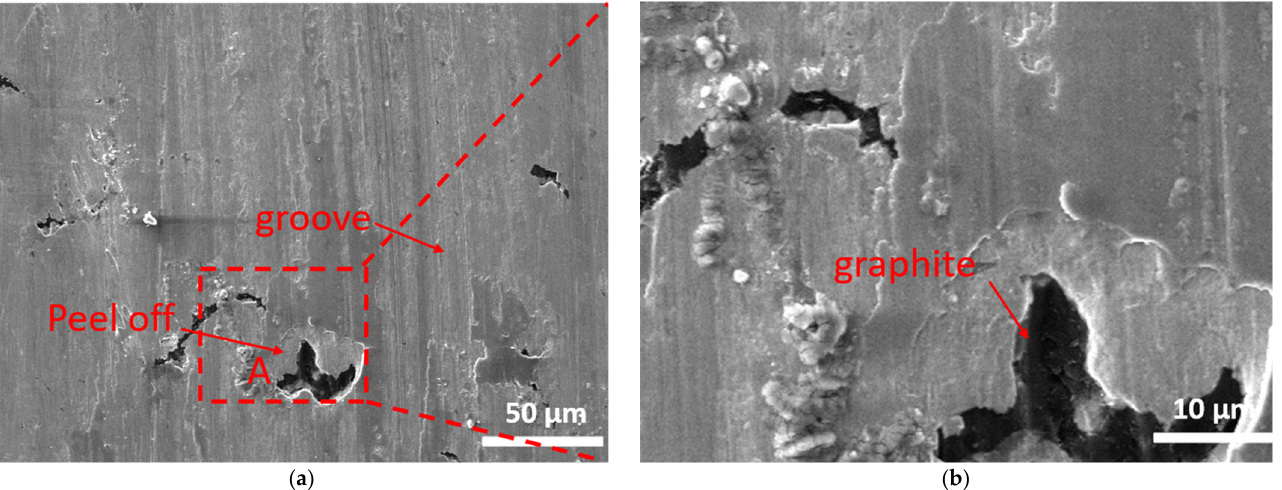
Figure 12. Worn surface morphologies ( a ) CGI substrate, ( b ) magnification of position A .